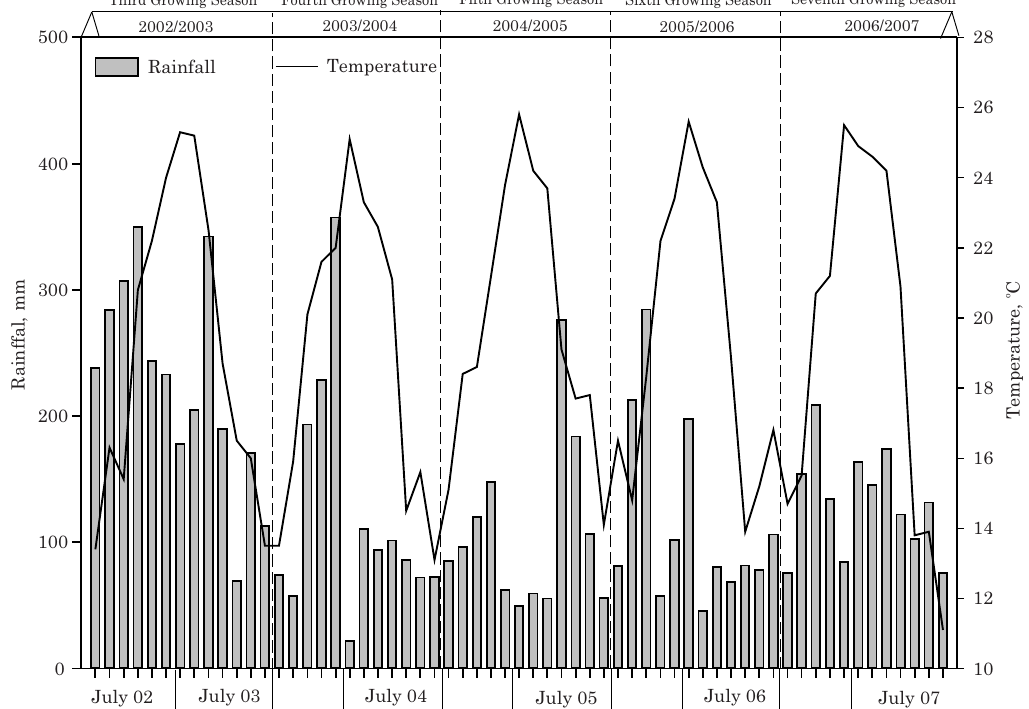
Figure 1. Accumulated rainfall and mean temperature in the growing seasons of 2002 to 2007 in the experimental area in Santa Maria, RS,